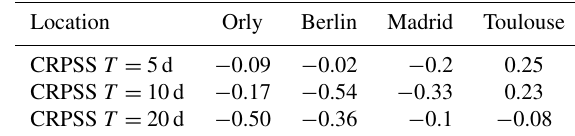
Table 6. CRPSS of ECMWF forecasts using as a reference the CRPS of SWG, for lead times of T = 5, 10, and 20d. The forecasts show that the SWG has a positive improvement compared with the ECMWF forecast as the CRPSS scores are above zero, except for that of Toulouse.